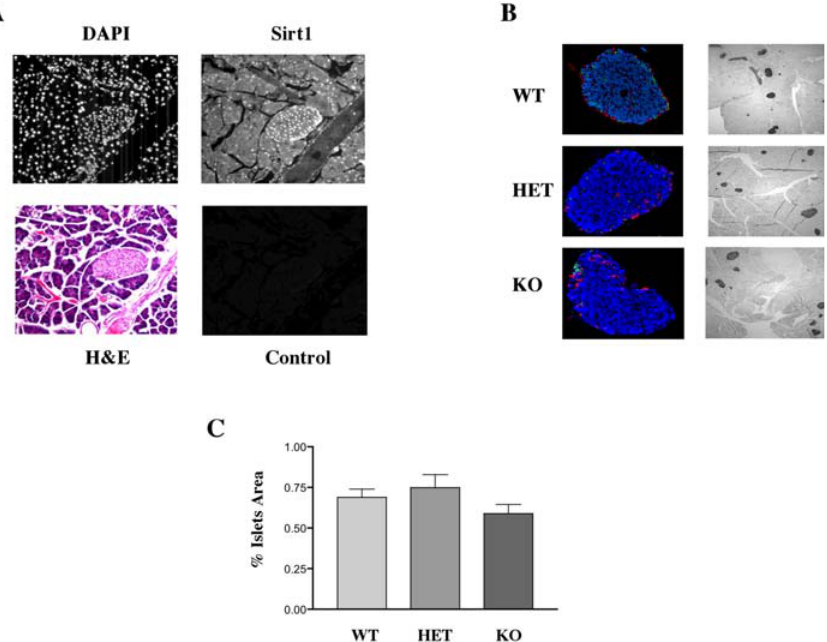
Figure 1. Sirt1 Is Localized in the Islets of Langerhans The pancreas of wild-type mice was sectioned and stained as described. (A) Nuclear staining using DAPI (top left). Immunofluorescence using Sirt1 antibody (top right); hematoxylin and eosin staining of the same section of pancreas (bottom left); immunofluorescence control using a rabbit secondary antibody (bottom right). (B) Pancreases of wild-type (WT), Sirt1 þ / (cid:1) heterozygotes (HET), or Sirt1 (cid:1) / (cid:1) homozygous KO mice were stained with antibodies against insulin (blue), glucagon (red), or somatostatin (green) (shown in left column). Representative islets of mice of all three genotypes are shown. Pancreases were also silver-stained for morphometry (right column). Islets appear as dark figures and their area was determined by scanning, using Image-Pro 4.1 Plus software. (C) The areas are shown as percentage of area of the entire pancreas. DOI: